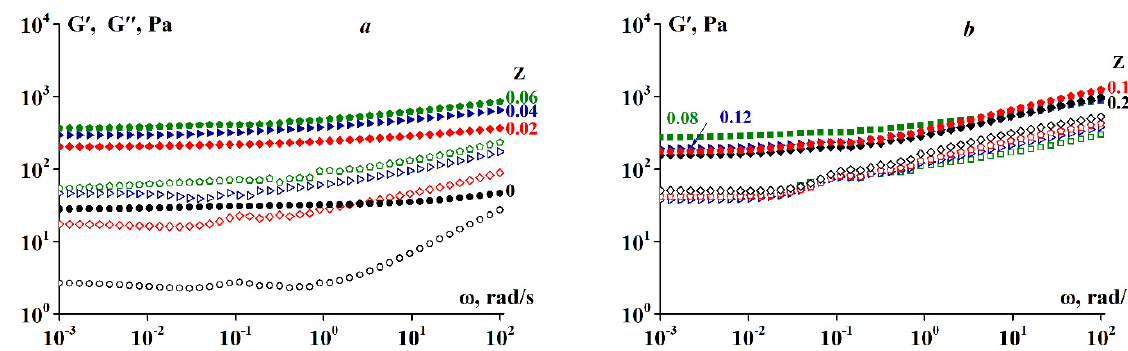
Figure 7. ( a ) G (cid:48) (closed symbols) and ( b ) G (cid:48)(cid:48) (open symbols) moduli dependency on frequency at 4 ◦ C at varying Z. Gelatin concentration was 10 wt.%. Z values are shown on the